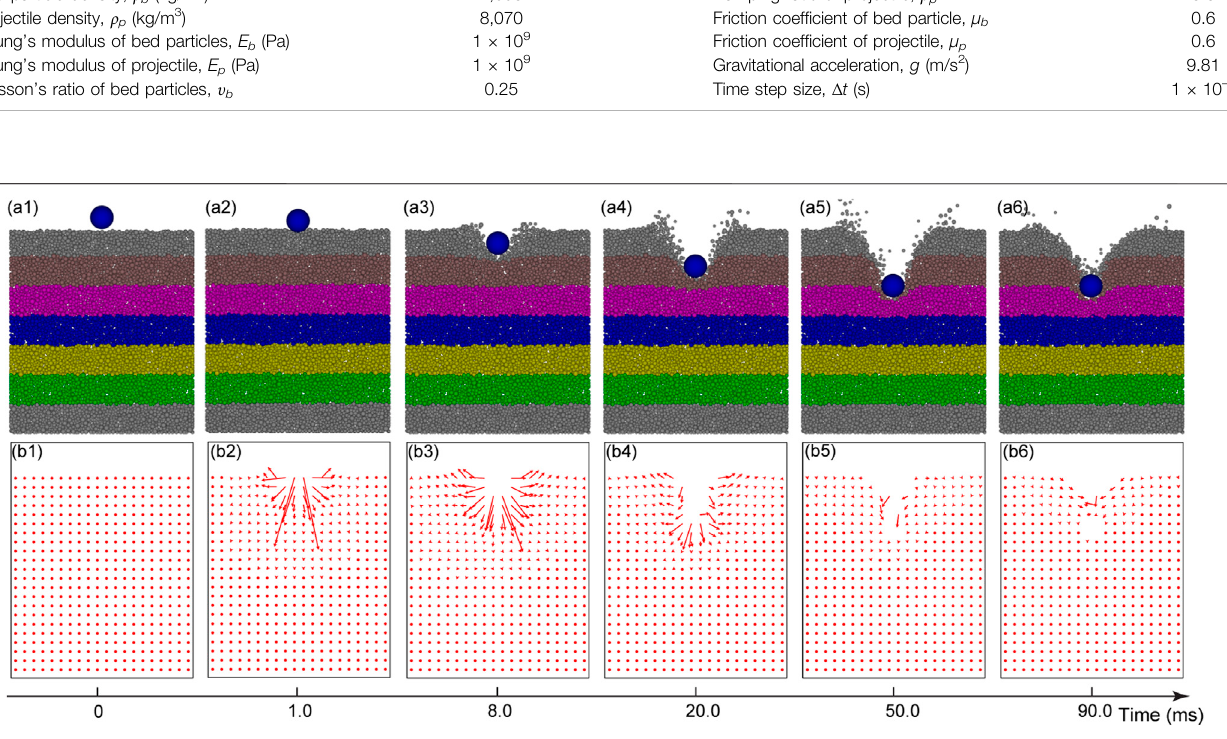
FIGURE3| Snapshots ofaprojectilecollidingintoagranularbed from t =0 – 90 ms( v 0 =5.0 m/s). Theseries (a1 – a6) aresnapshots ofa1 cmthick vertical sliceof the model through the axisymmetric center ofthe granular bed. The series (b1 – b6) are the correspondingvelocity fi elds. The length ofthe arrow isscaled bythe velocity magnitude. The velocities smaller than 0.01 m/s are plotted as